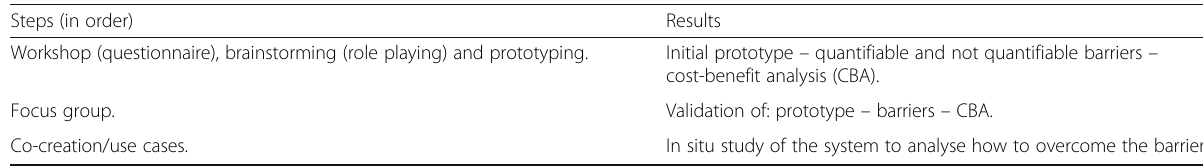
Table 2 UDI elicitation techniques selected from Carrizo et al.